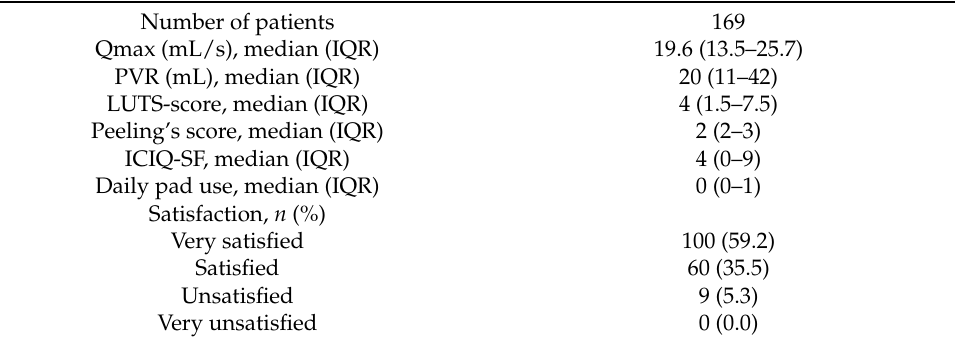
Table 6. Post-DAU clinical parameters including patient-reported outcomes.